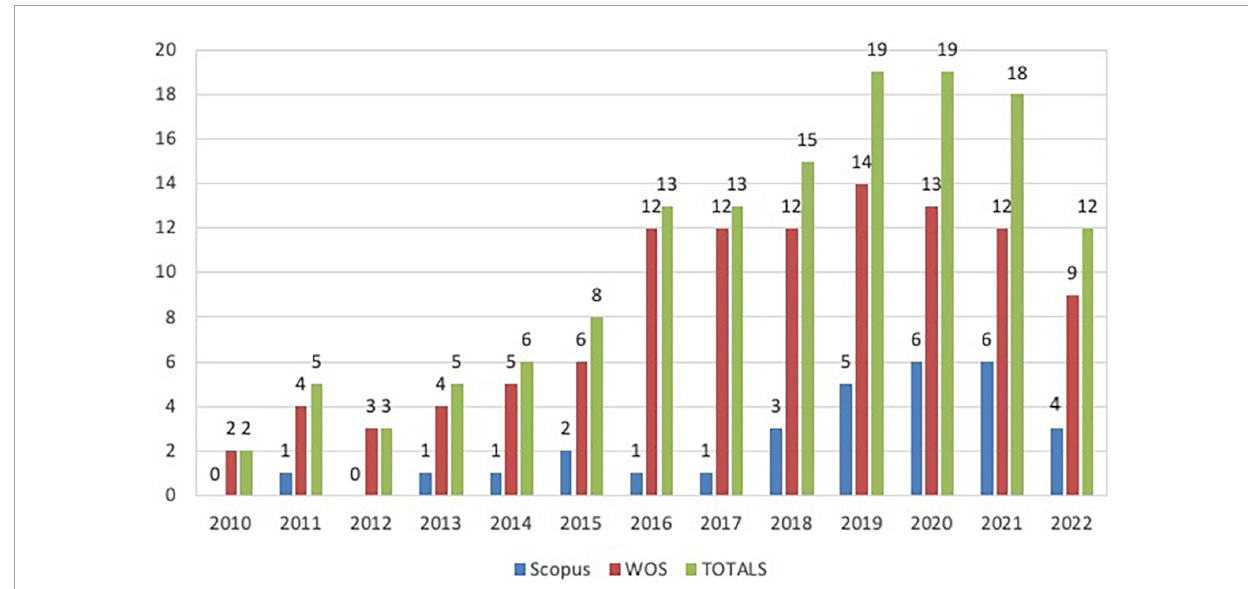
FIGURE2 Articles published in the last 12 years in Scopus and Web of Science on the causes of academic dropout in higher education in Spain. Source: Own elaboration.